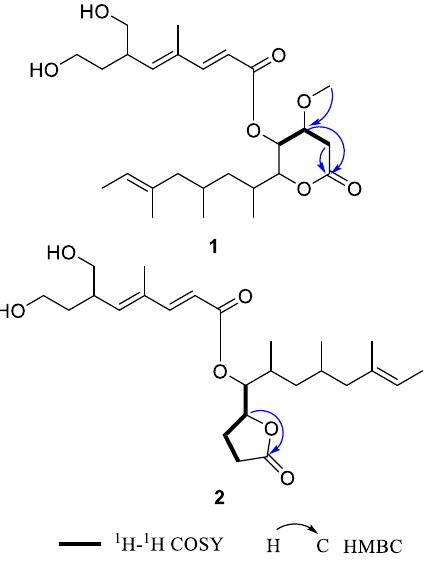
Fig. 2 Key 2D NMR correlations of compounds 1 and 2